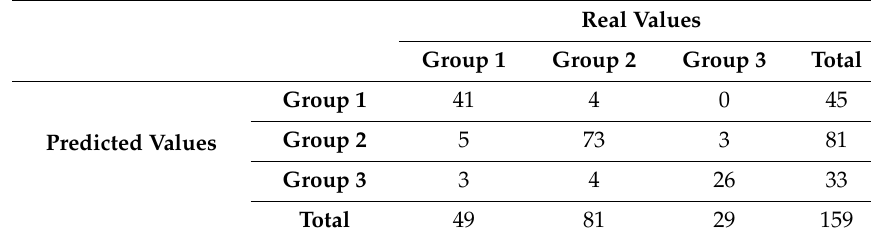
Table 6. Confusion matrix for the final classification model of Figure